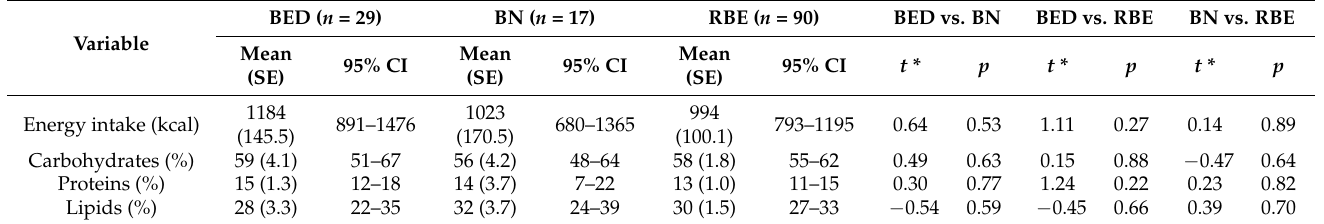
Table 4. Energy intake and macronutrient consumption during objective binge eating episodes according to eating disorder